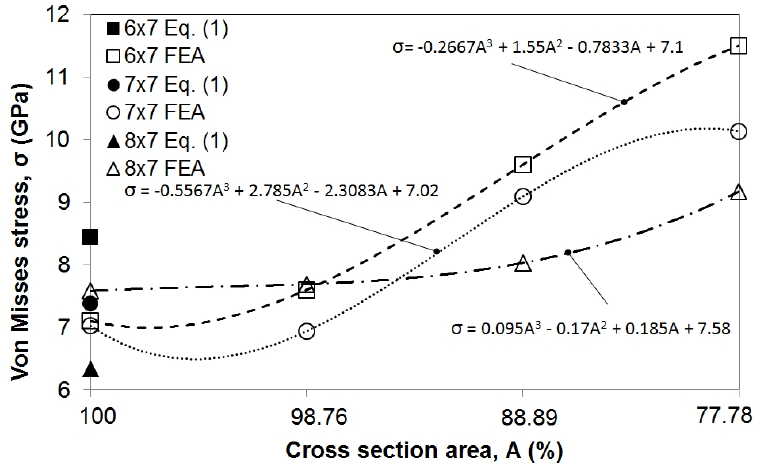
Figure 5. Von Misses stress levels for 6 × 7, 7 × 7, and 8 × 7 wire ropes with full and reduced cross ‐ section areas.